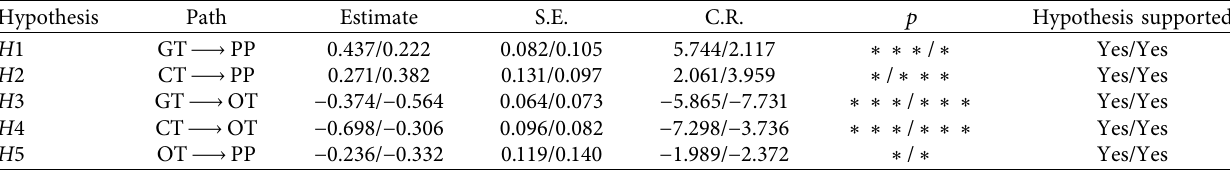
Table 7: Hypothesis test